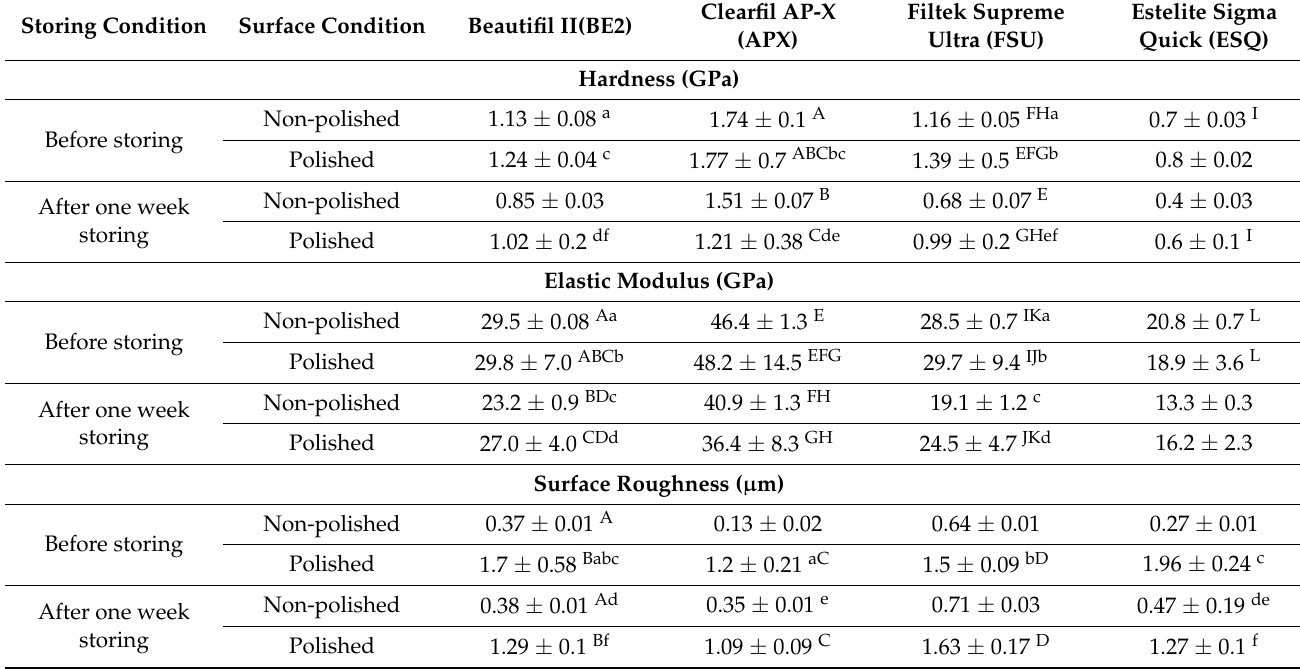
Table 2. Nanoindentation hardness, elastic modulus, and surface roughness tests before and after 25% ethanol exposure in polished and non-polished surfaces.